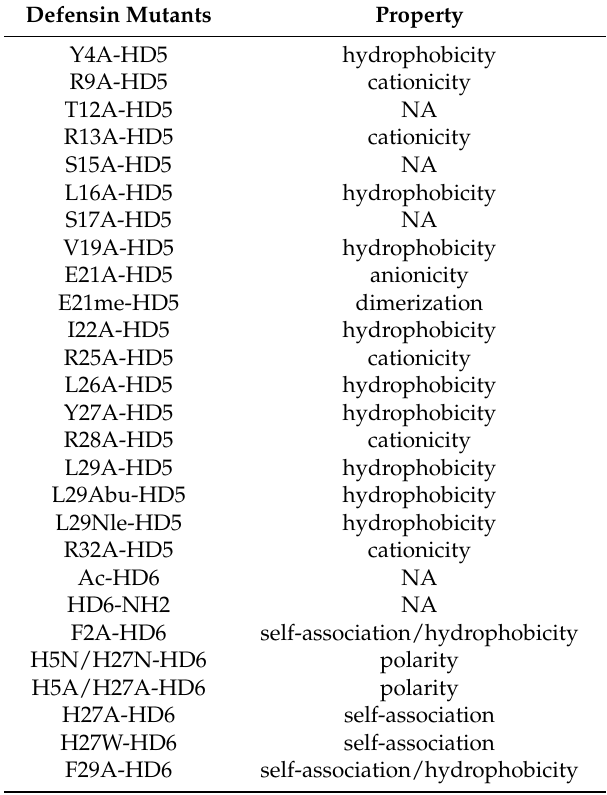
Table 1. Human α -defensin 5 and 6 (HD5 and HD6) mutants and properties of mutated amino acid residues. NA: information is not